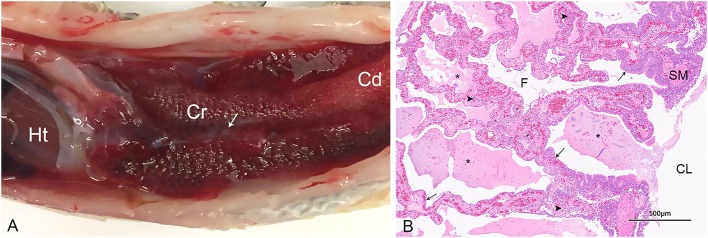
Gross and histologic pulmonary lesions in a serpentovirus-positive green tree python from collection A (snake A26). (A) The lungs are markedly thickened and dark red, especially in the cranial (Cr) lung compared to the caudal (Cd) lung. Small mucoid aggregates are present within the central lumen of the lung (arrow). The heart (Ht) is indicated for orientation. (B) Histopathology of the lung revealing proliferative and interstitial mucinous pneumonia characterized by excessive mucus, edema, and necrotic debris (asterisks) within the central lumen (CL) and faveoli (F), marked epithelial hypertrophy and hyperplasia lining faveoli (arrows), and mixed chronic-active inflammation within thickened faveolar septa (arrowheads). These lesions are consistent with serpentovirus infection. SM, smooth muscle. Hematoxylin and Eosin. 40× magnification.